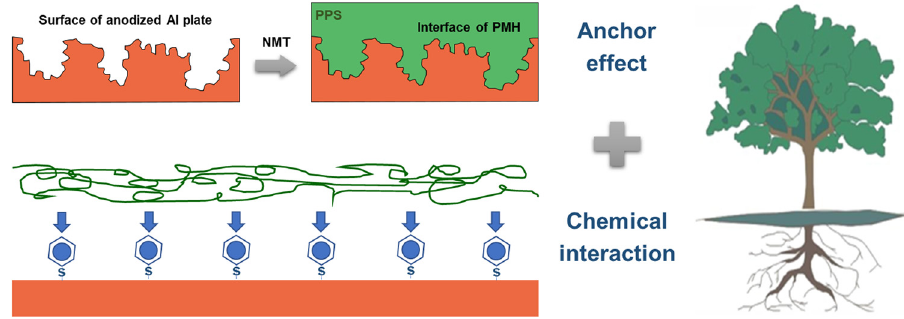
Figure 7: Schematic illustration of the bonding mechanism of